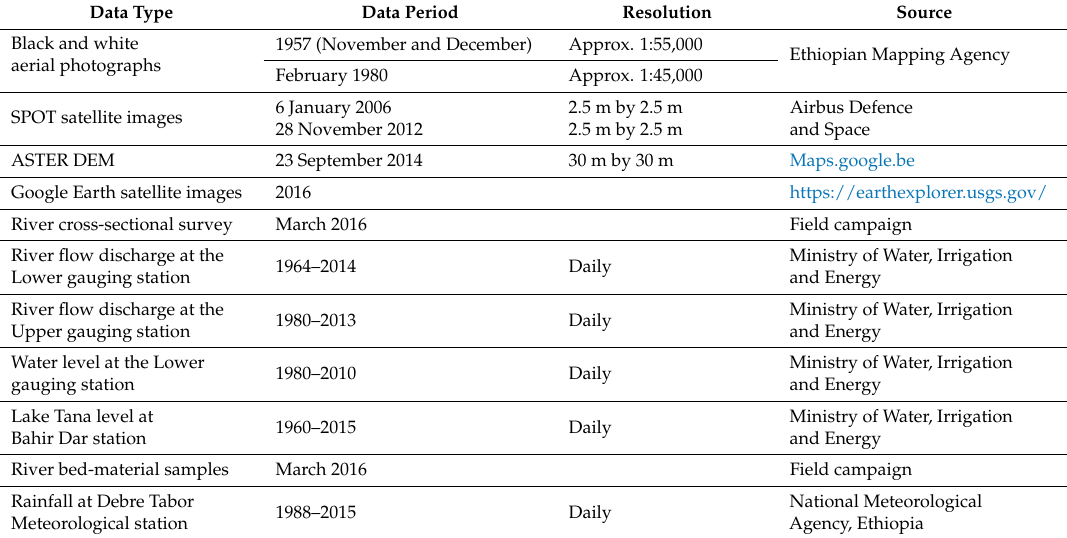
Table 1. Collected data and their